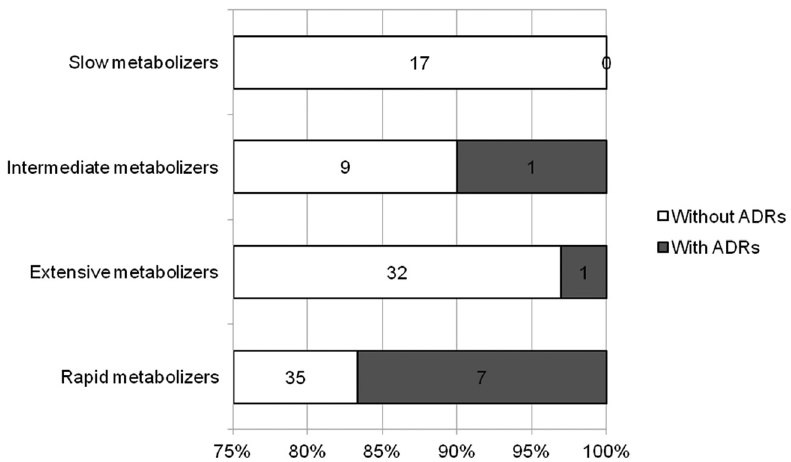
Figure 1: Distribution of ADRs to clopidogrel according to the CYP2C19 enzyme activity. Numbers inside the bars indicate participants without and with ADRs to clopidogrel.